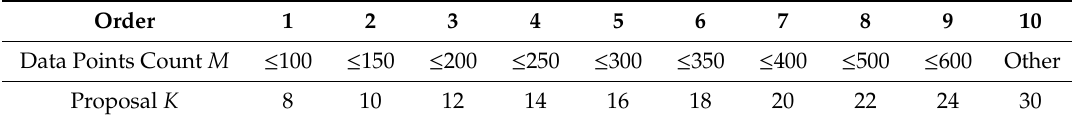
Table 3. Proposal parameter K with di ff erent data points of the reference signature.